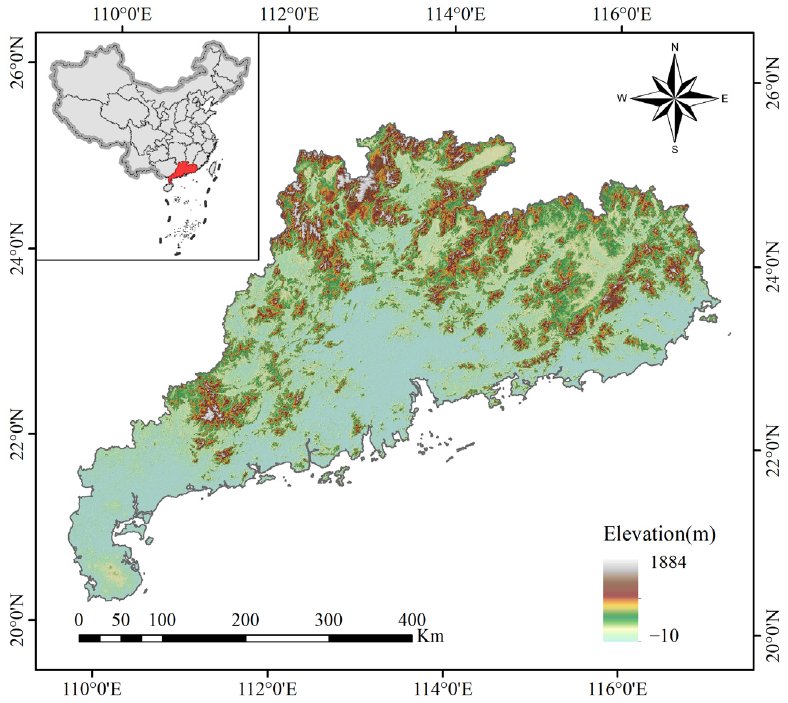
Figure 1. Location of Guangdong province together with the DEM.